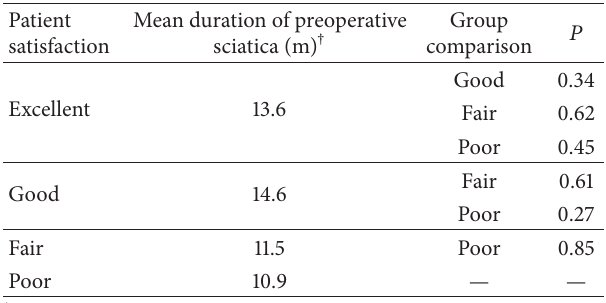
Table 4: The correlation between mean duration of preoperative sciatalgia and postoperative patients’